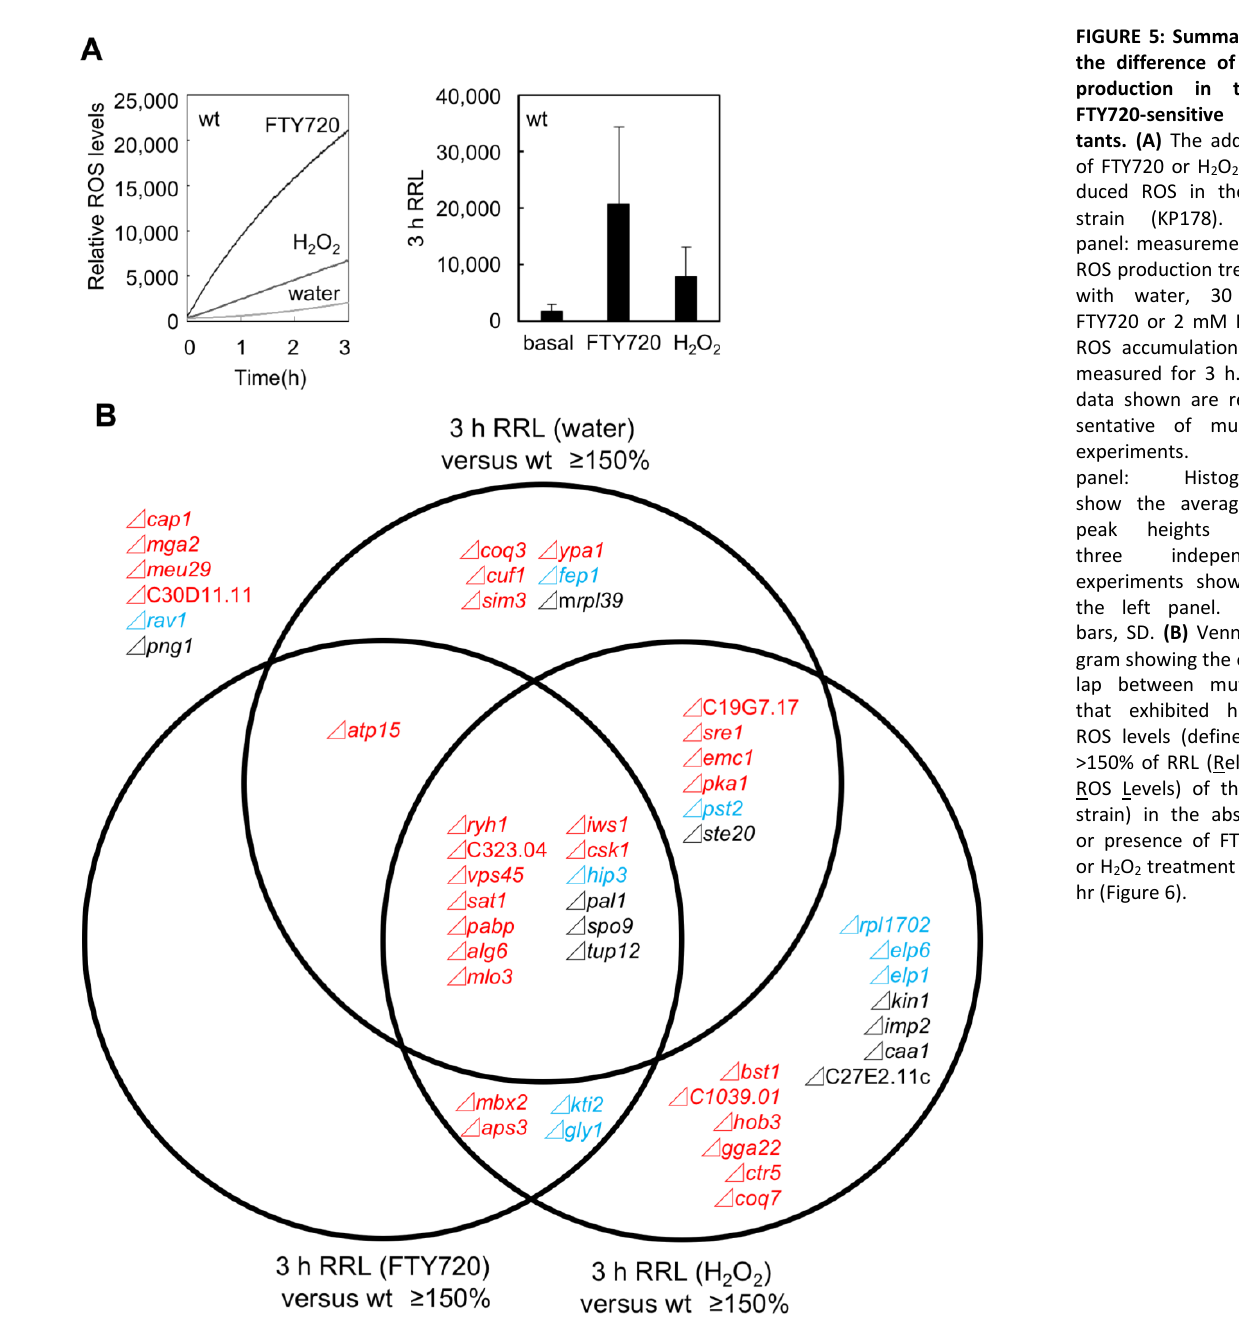
panel: measurement of